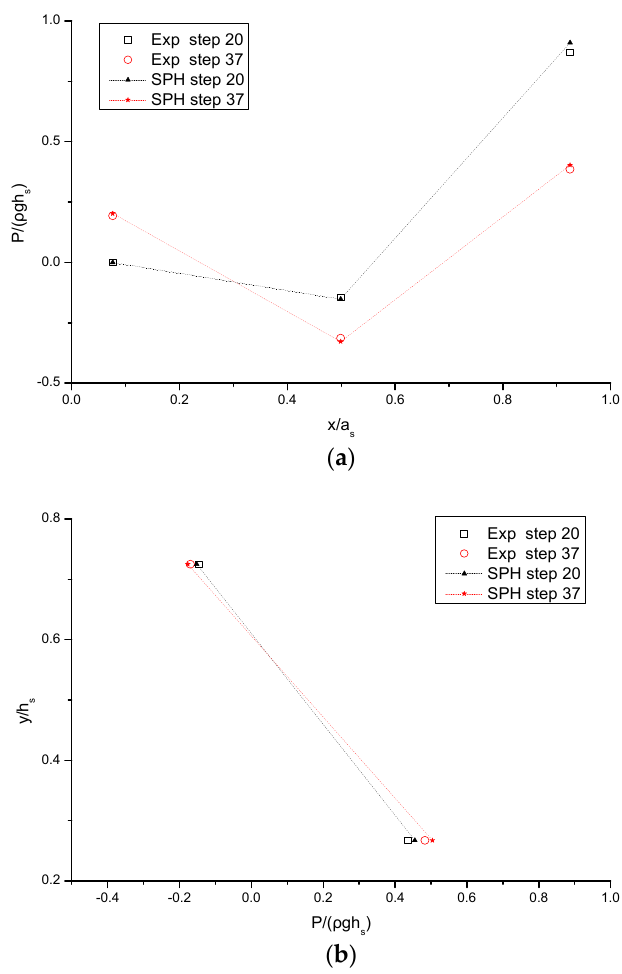
Figure 11. Pressure distributions on: ( a ) Horizontal; ( b ) Vertical step faces, for the 45-step spillway case.